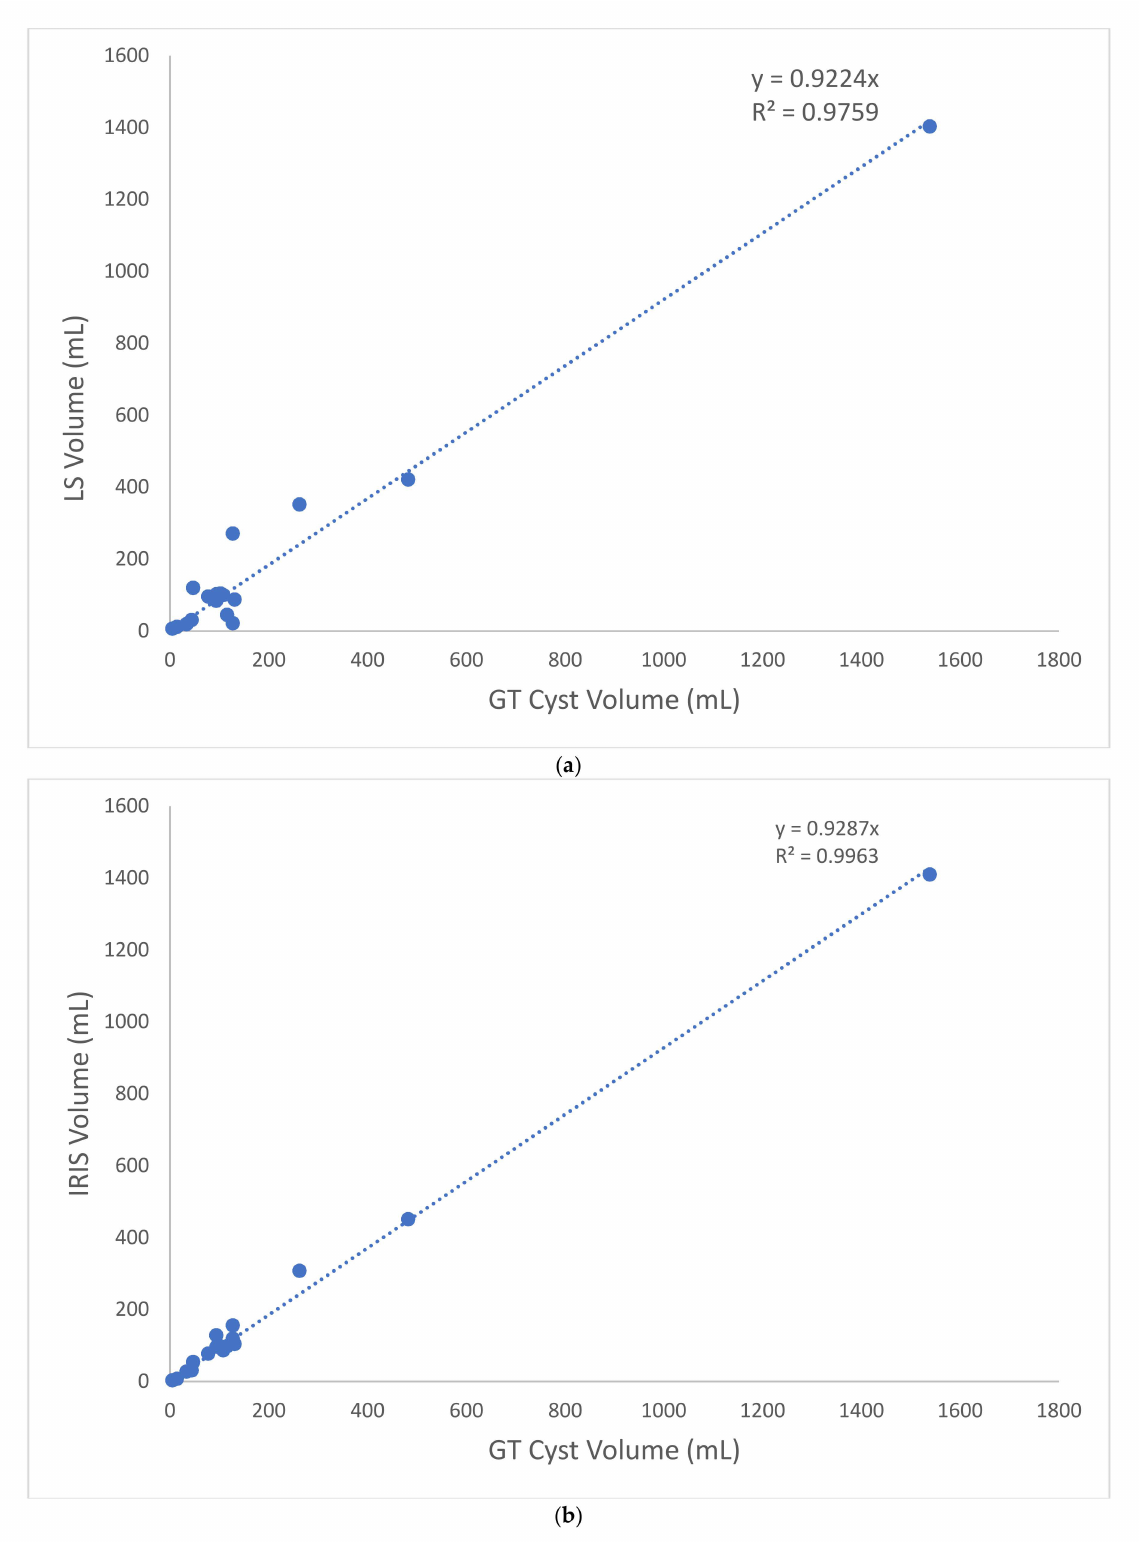
Figure 2. Scatter plots of liver cyst volume measurements by ( a ) LS and ( b ) IRIS against GT. IRIS im- proved regression slope and regression coefficient. GT = ground truth segmentation, LS = automatic level set segmentation, and IRIS = intelligent rapid interactive